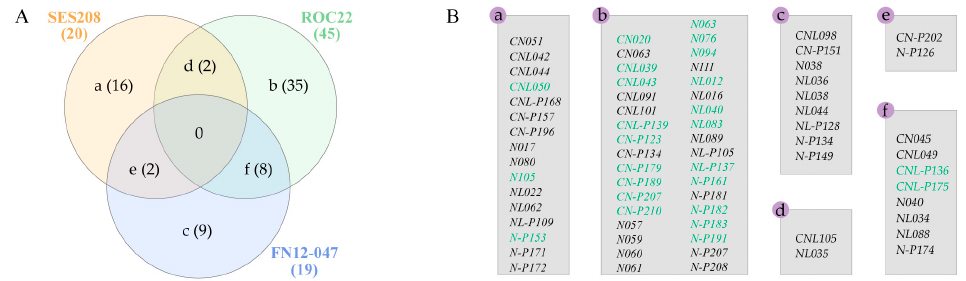
Figure 6. Comparisons of expression of NLR in three sugarcane accessions in response to sugarcane leaf blight (SLB). ( A ) Venn diagram of the differentially expressed NLR gene (DENLR) sets derived from three clones of SES208, ROC22, and FN12-047. ( B ) Specific members of each DENLR set. The genes labeled green were downregulated DENLRs.